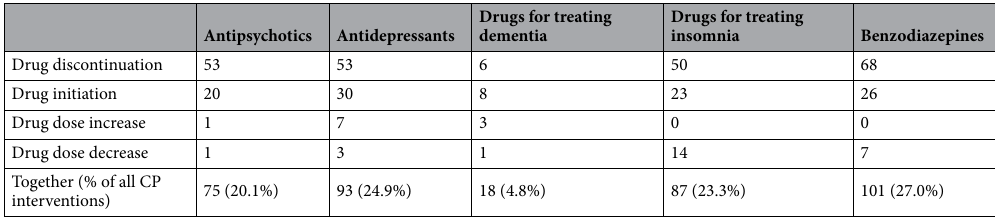
Table 1. Clinical pharmacist intervention types by psychotropic group (CP = clinical pharmacist).